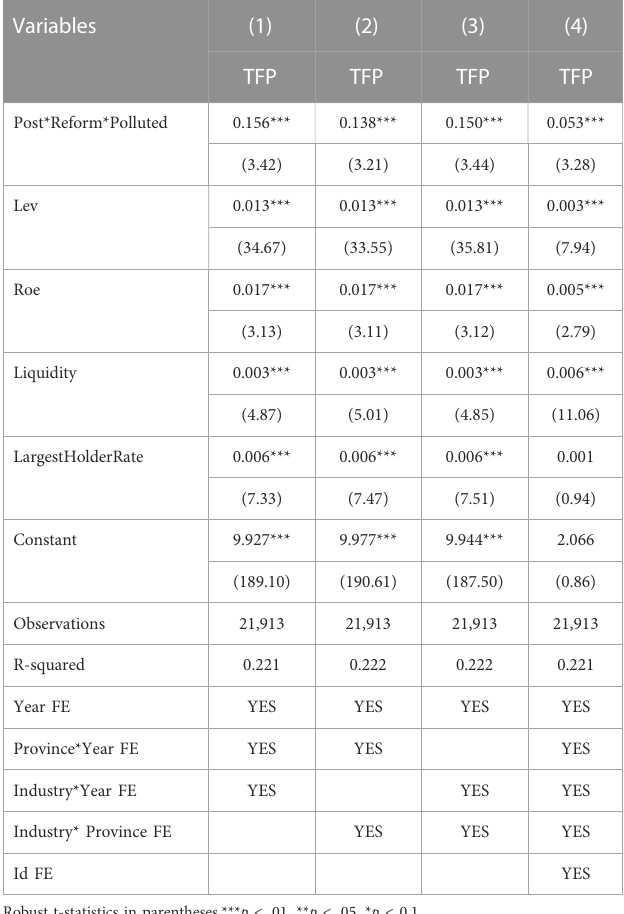
TABLE 2 The impact of environmental protection tax policy on total factor